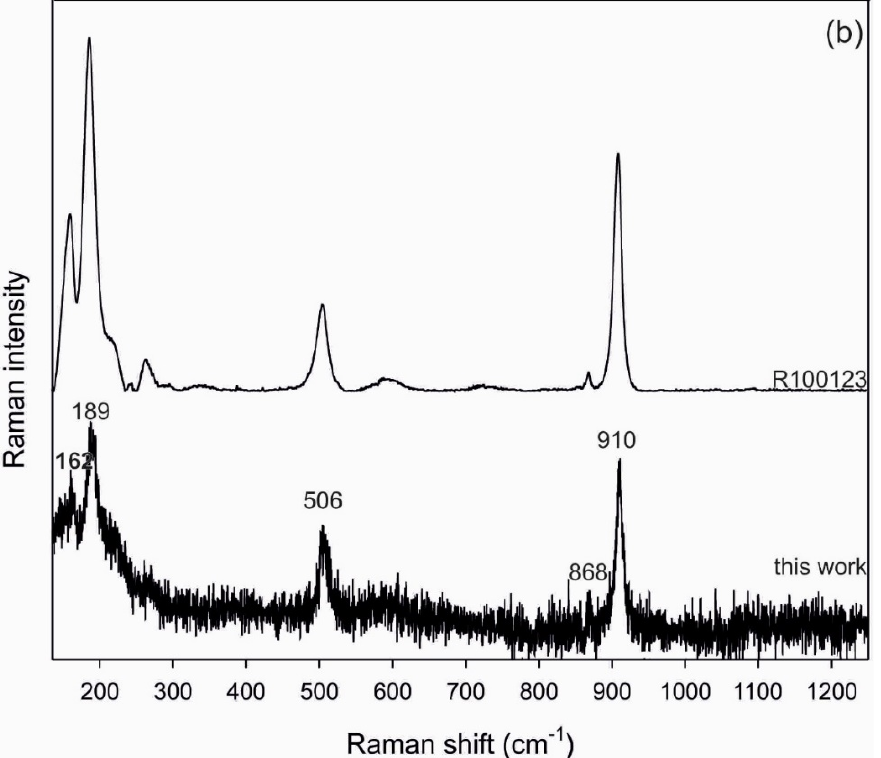
Figure 7. Raman spectrum of weddellite ( a ) in the C-C stretching region and ( b ) in the range from 100 to 1300 cm -1 (the comparison to spectrum of weddellite sample R100123 from RRUFF database (rruff.org) is also provided).